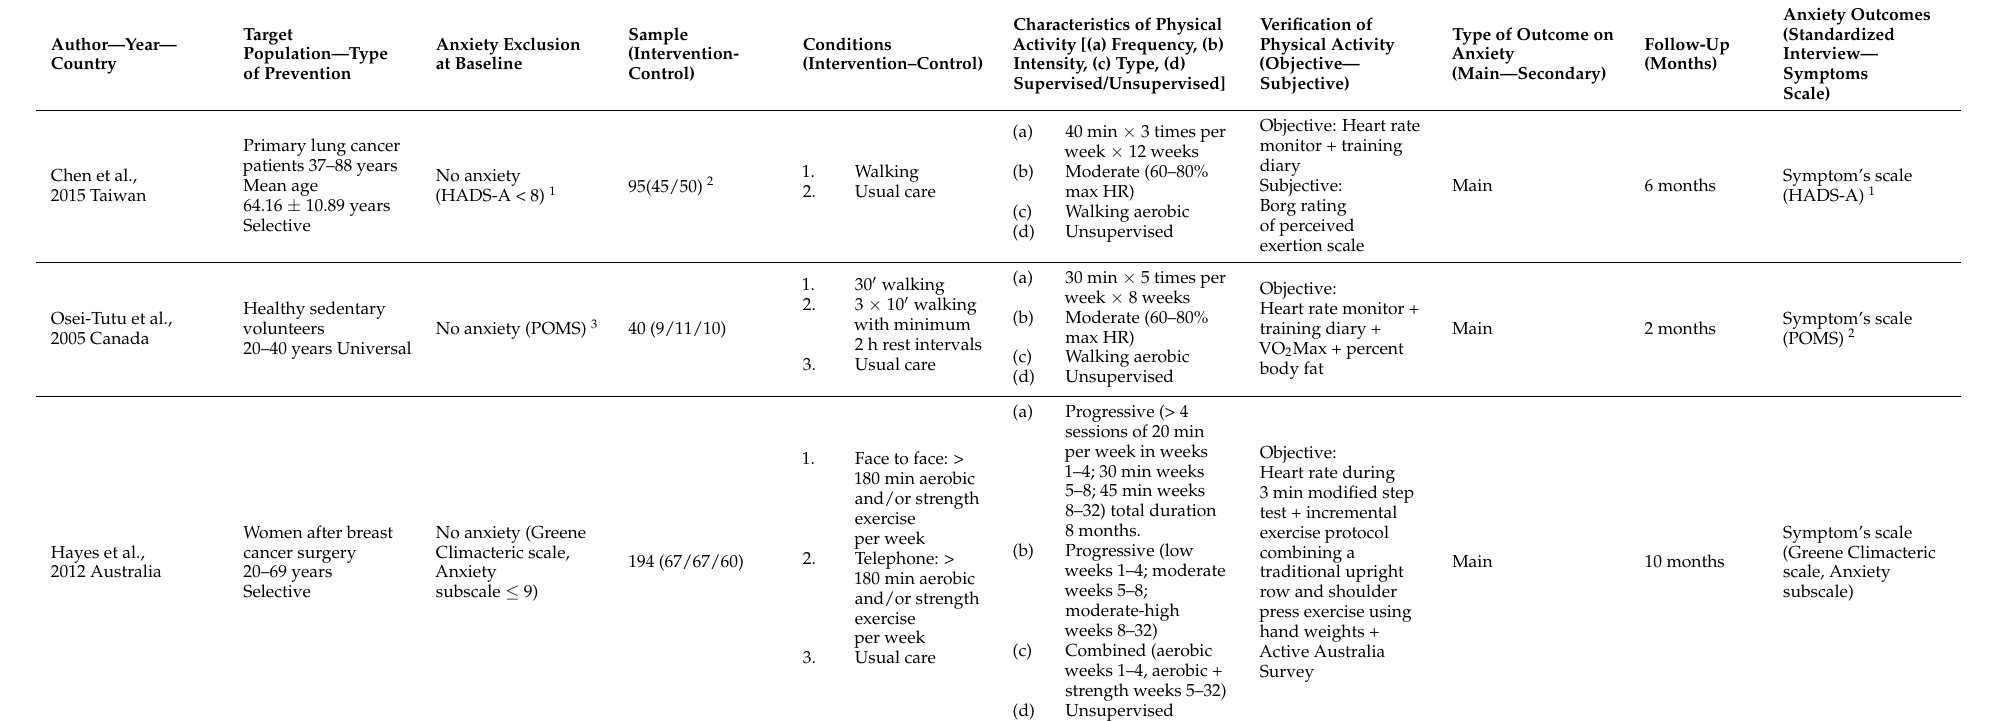
Table 1. Characteristics of randomized controlled trials